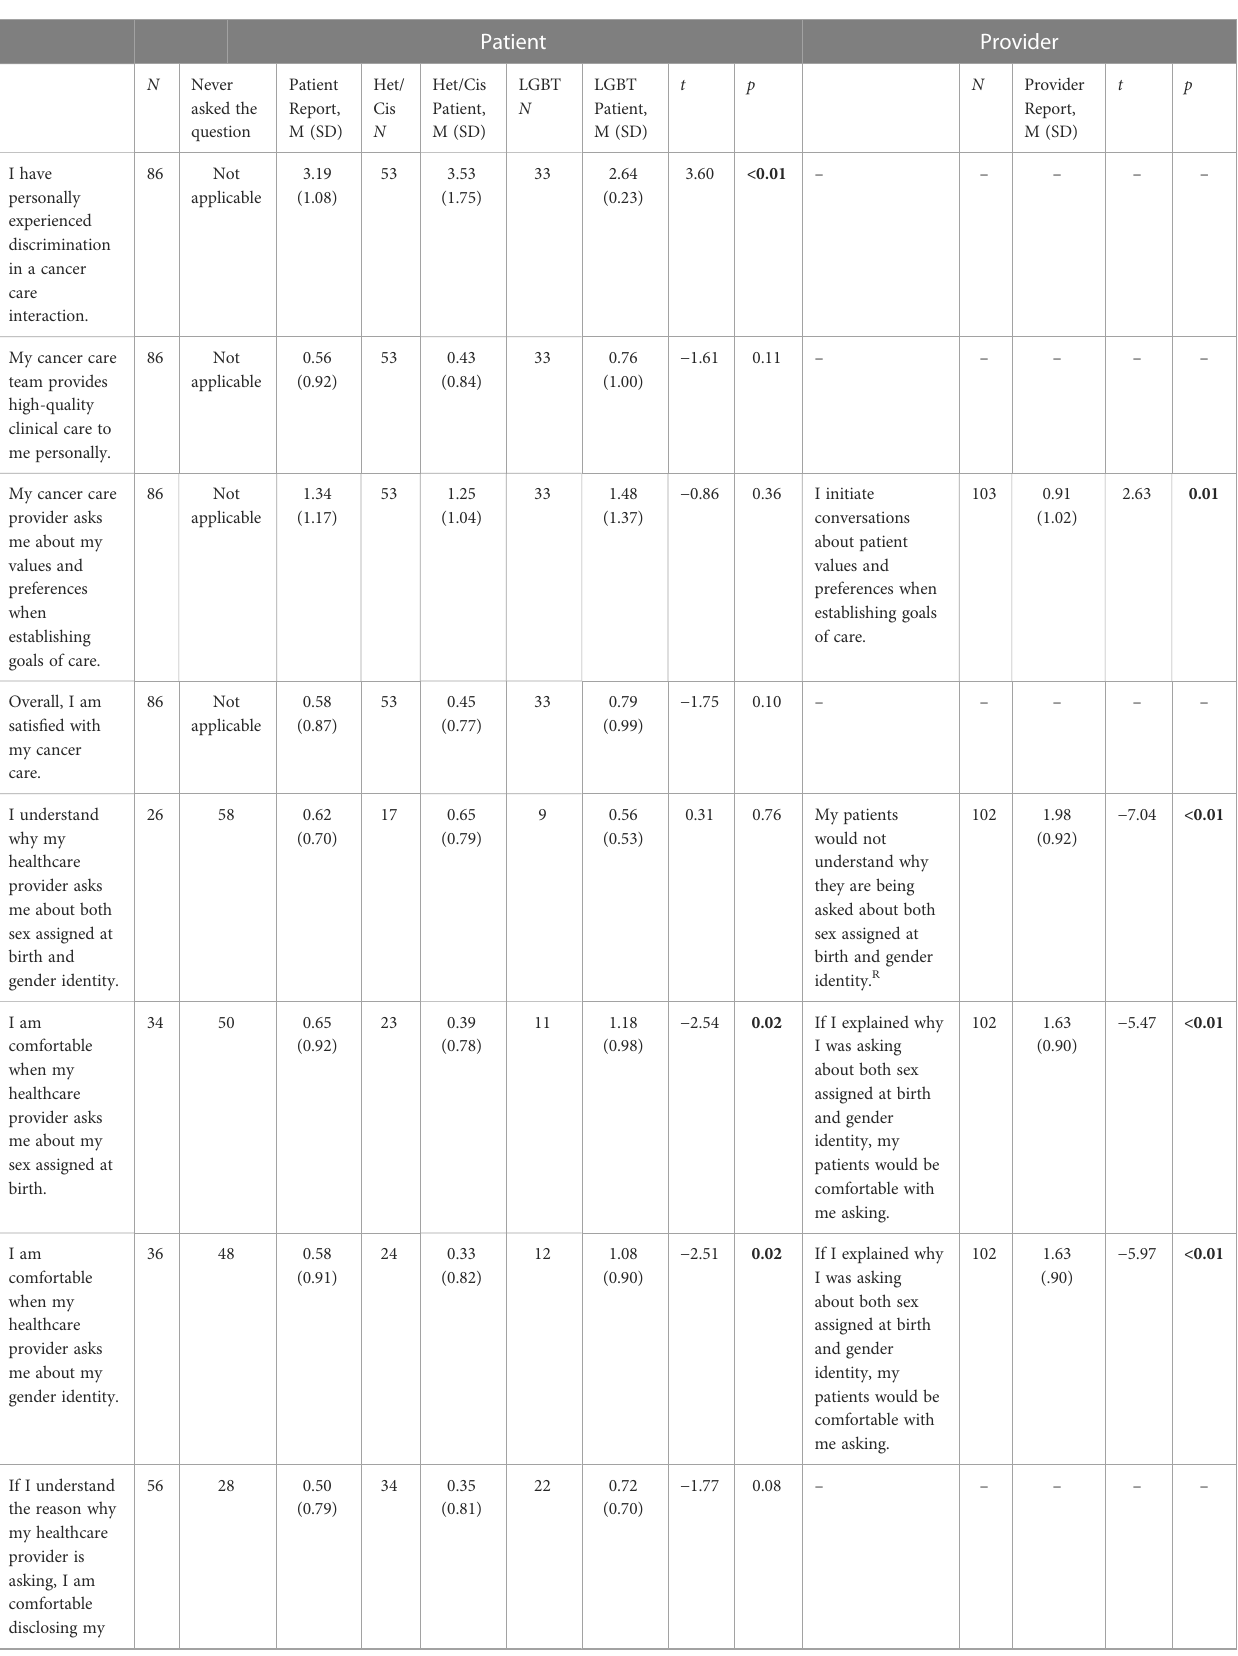
TABLE 4 Patient and provider reported experiences of LGBTQI-af fi rming provider